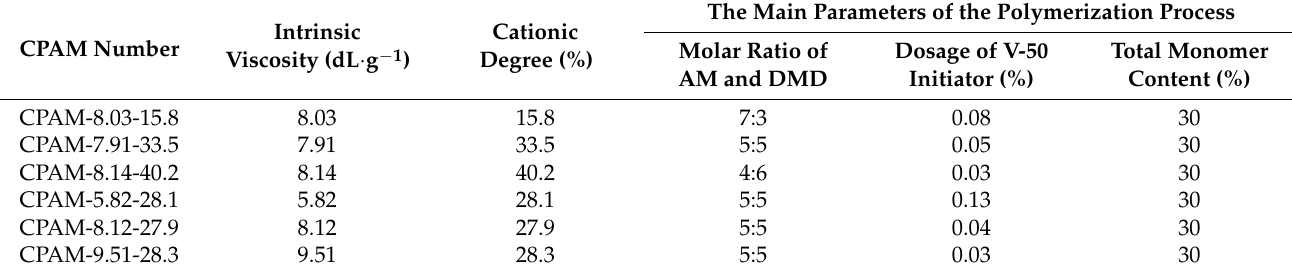
Table 1. Information about the CPAM products used in the flocculation test.